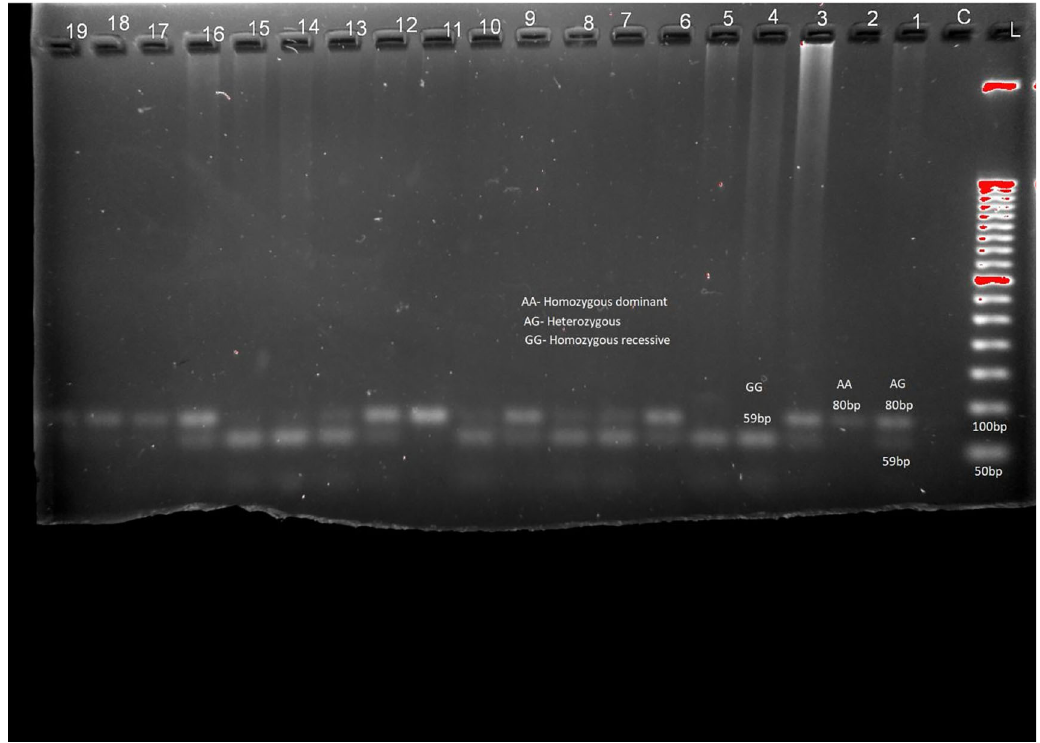
Figure 2. Sample pattern of distribution of alleles of Leptin receptor gene (LEPR). Association studies among insulin resistance and genes for leptin were carried out. No significant association was found between them (chi- square0.221, p = 0.638(Table3). There was alsoanon-significant link between Leptinreceptor gene polymorphisms and insulin resistance (chi-square value = 0.1275, p value = 0.721). In patients with alleles for the leptin/LEPR genes, odd's ratio revealed no risk of insulin resistance (Table